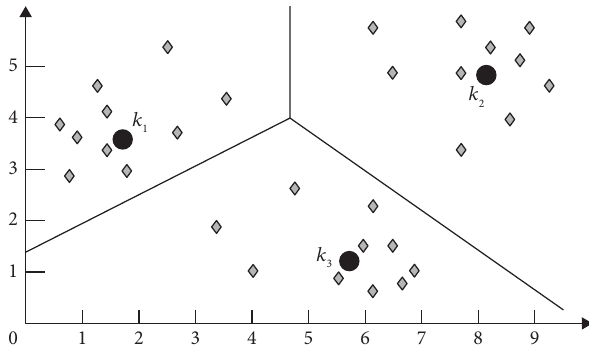
Figure 1: K-means clustering result under stable